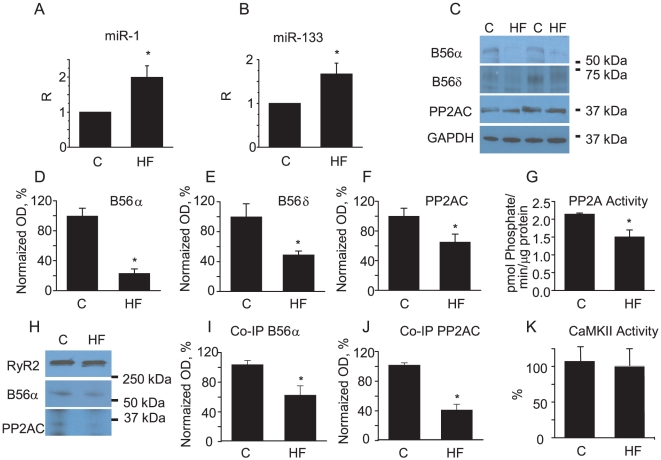
Changes in Expression Levels of miR-1 and miR-133 and their targets in canine HF Myocytes.A, B. Normalized levels of miR-1 and -133 assessed with qRT-PCR. *p<0.05, n = 5. C. Representative Western blots of putative targets of miR-1 and -133, regulatory subunits B56α, B56δ and catalytic subunit of PP2A respectively. D,E,F. Normalized optical density (OD) for B56α, B65δ and catalytic subunit of PP2A respectively; *p<0.05, n = 8. Note that anti-PP2AC antibody recognizes both α and β isoforms. G. Total PP2A activity is samples prepared from LV tissues of normal and failing hearts, *p<0.05, n = 4. H,I,J. Decrease in levels of PP2A scaffolded to RyR2 tested using coimmunoprecipitation with anti-RyR2 antibodies; (H) representative Western blots and pooled data for B56α (I) and PP2AC (J), *significantly different vs. control, p<0.05, n = 6. K. Local CaMKII activity measured in samples with immunoprecipitated RyR2s (n = 4). Local CaMKII activity levels and levels of PP2AC and B56α were normalized to the levels of RyR2s.